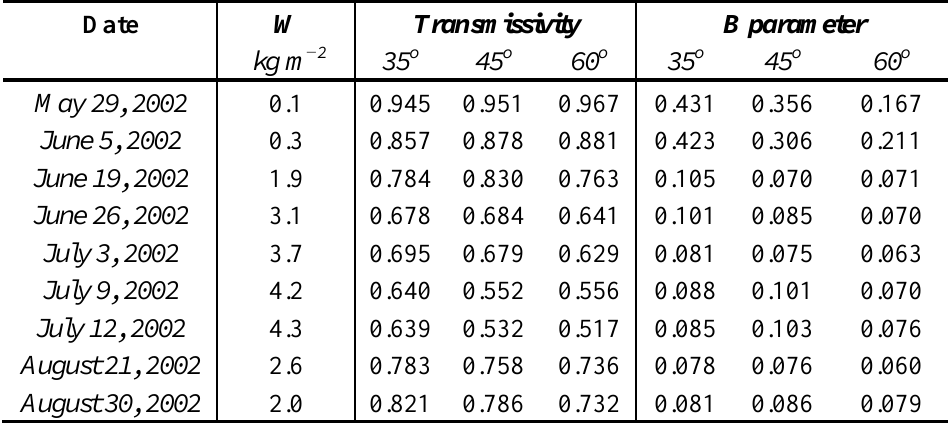
Table 3. H-polarized transmissivities and b parameters estimated over the 2002 corn growth cycle using multi angular brightness